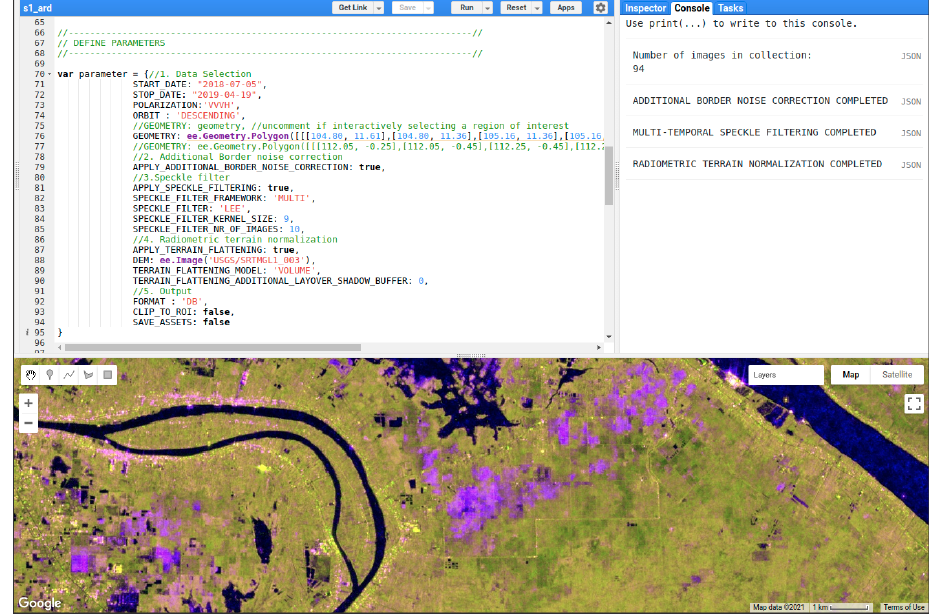
Figure 3. A screenshot of the GEE JavaScript code editor window.